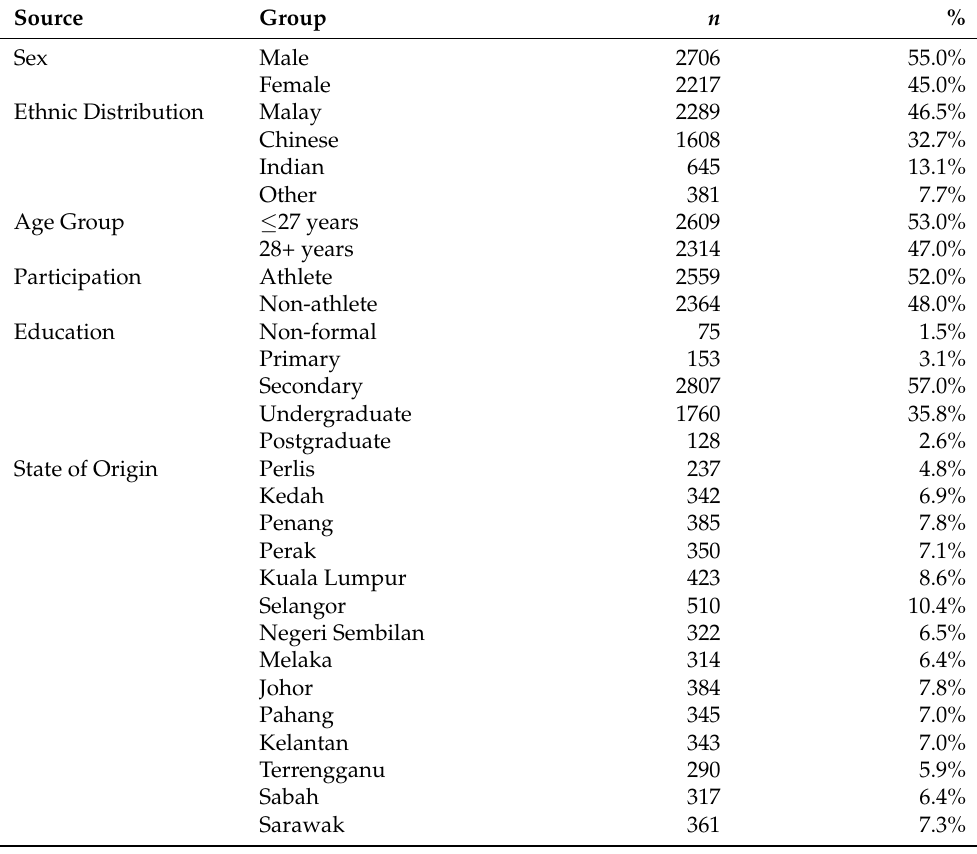
Table 1. Demographic distribution of the sample ( n =